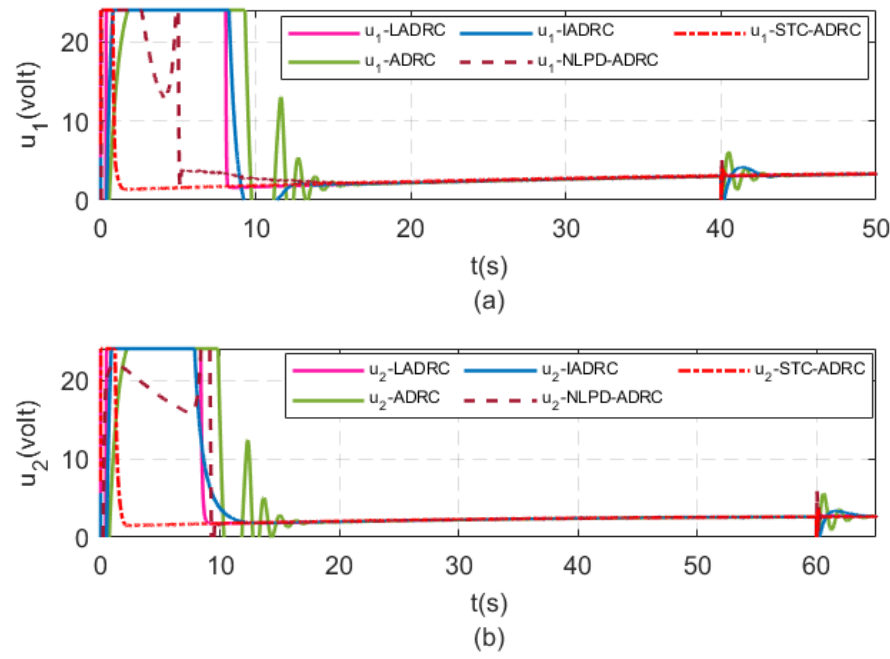
Figure 6. The control signal when using the 1 st MADRC scheme. ( a ) 1 st subsystem. ( b ) 2 nd subsystem. Figure 7a,b show the control signal of the first subsystem and the second subsystem, respectively. It is observed that the second MADRC scheme (i.e., D f al -ADRC-TD) is chattering-free with a smooth response, while the other methods, such as ADRC, show chattering in the control signal. This proves the effectiveness of the proposed method.